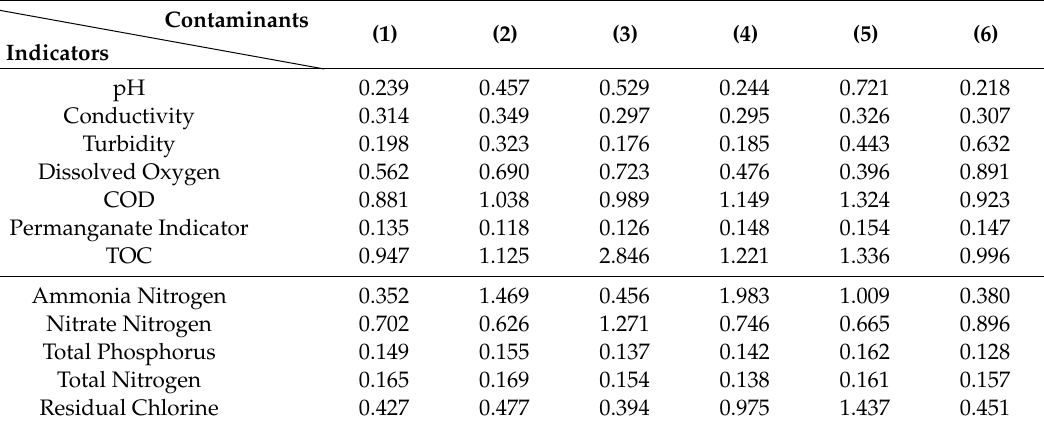
Table 3. The results of single indicator fluctuation analysis.